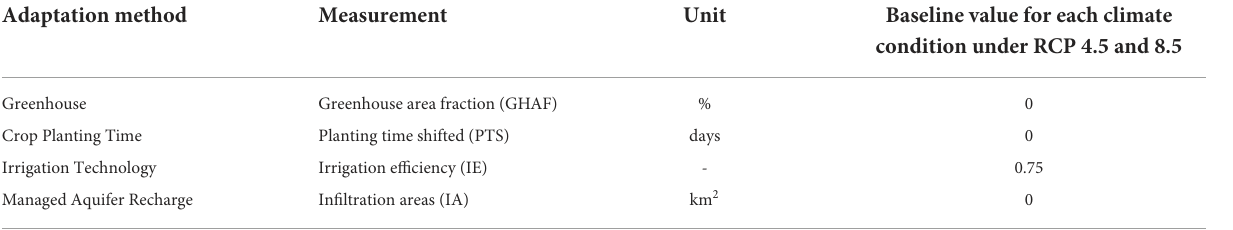
TABLE 3 Baseline values for four methods in their measurement